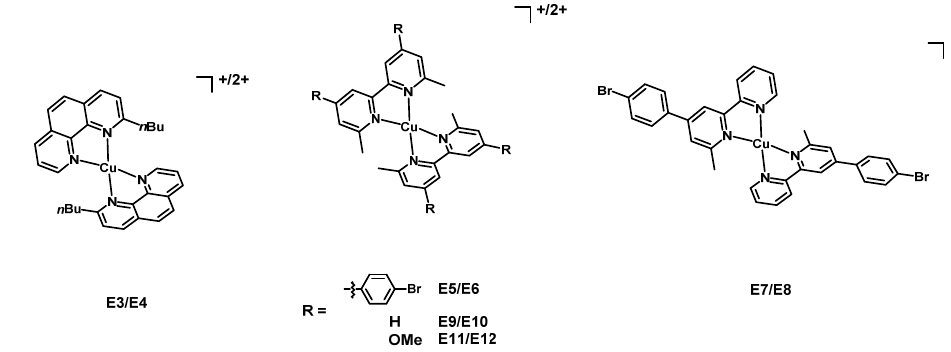
ε = 8.0 × 10 3 M − 1 cm − 1 , E2 : λ ε = 2.3 × 10 4 M − 1 cm − 1 , E3 : λ max = 741 nm, max = 452 nm, M − 1 cm − 1 , E2 : λ max = 741 nm, ε = 2.3 × 10 4 M − 1 cm − 1 , E3 : λ max = 452 nm, ε = 6.2 × 10 3 M − 1 cm − 1 , ε = 6.2 × 10 3 M − 1 cm − 1 , E4 : λ ε = 9.6 × 10 5 M − 1 cm − 1 ). Cyclic max = 756 nm, E4 : λ max = 756 nm, ε = 9.6 × 10 5 M − 1 cm − 1 ). Cyclic voltammetry experiments demonstrated